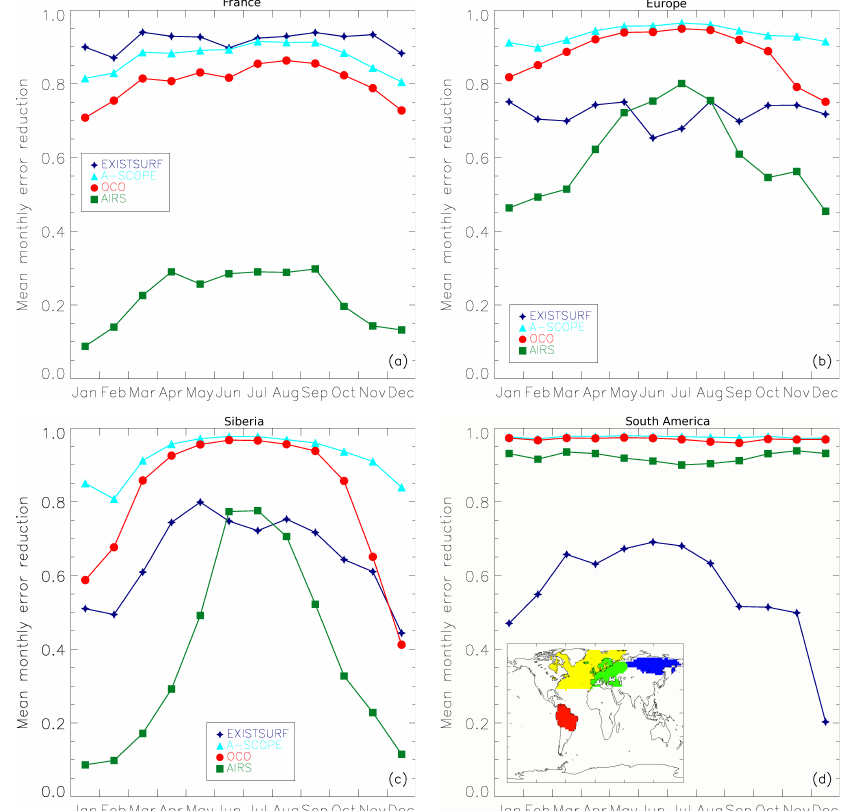
Fig. 5. Time series of the monthly error reduction of the monthly fluxes in (a) France, (b) Europe, (c) Siberia and (d) South America for four selected observing systems (EXISTSURF, A-SCOPE2.0, OCO and AIRS). The regions considered (aggregates of several of the pre-defined 200 regions) are also visualised in (d).